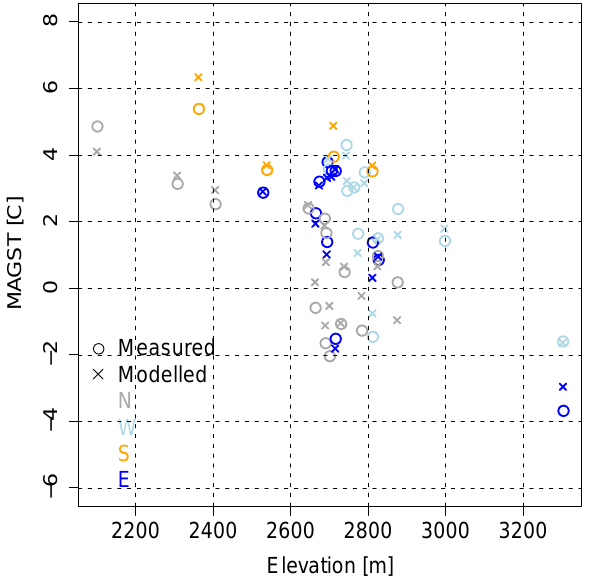
Table 2. 95% confidence intervals of the inter-footprint analysis coefficients (Model (3)).